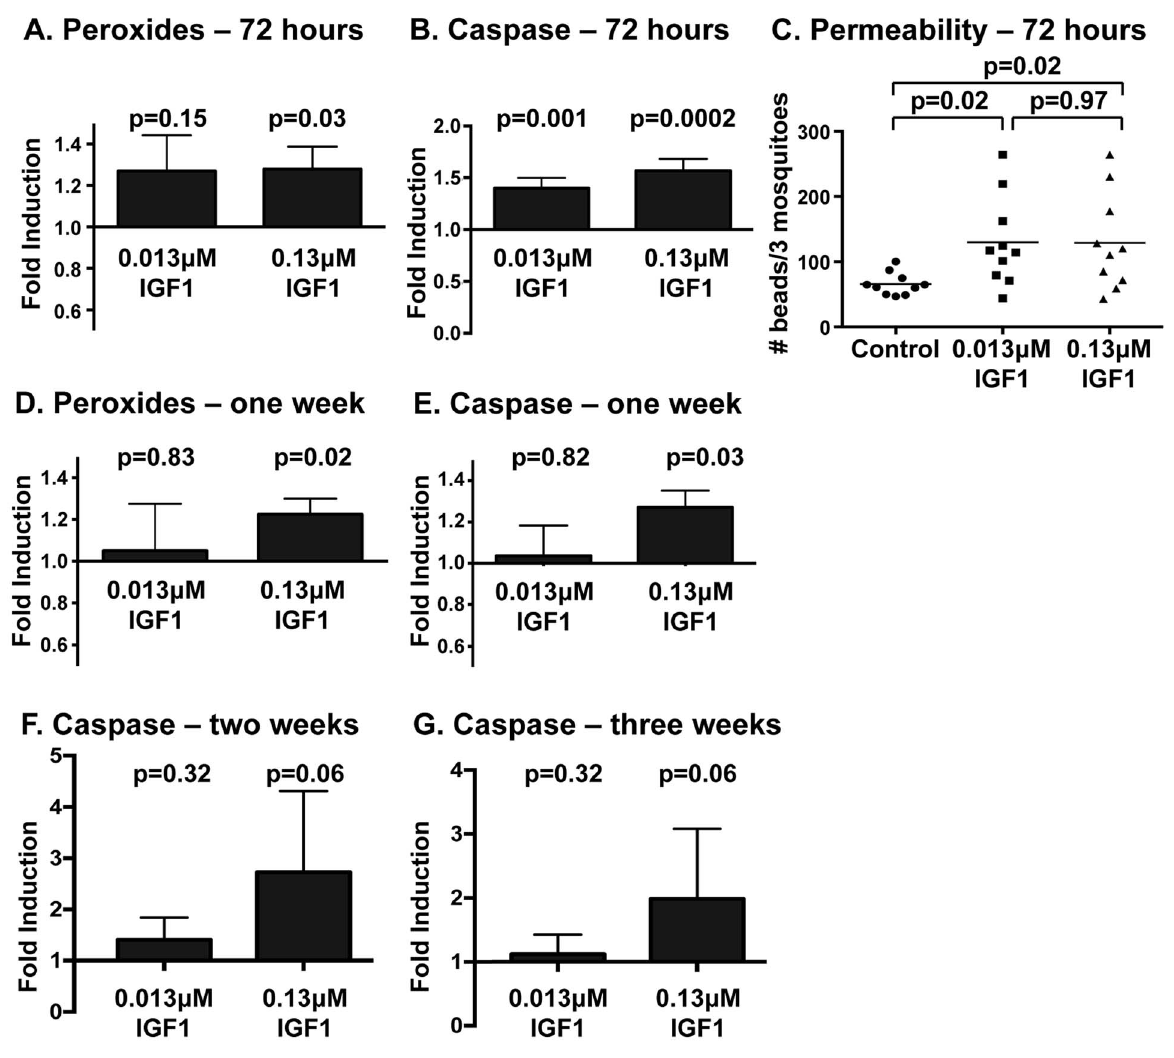
Figure 6. Midgut peroxides and epithelial integrity were altered at 72 h and one week post-IGF1 feeding. Peroxide levels in midguts at 72 h (A) and one week (D) following IGF1 treatment. Peroxides were quantified in pools of five midguts; three pools were collected per treatment per experiment. Experiments were replicated three times with separate cohorts of mosquitoes. Graphs show the mean fold induction of peroxides 6 SEM in IGF1 treated groups relative to saline/ATP-fed controls. Statistical significance was determined by unpaired t-test and p-values are indicated. Midgut caspase-3 activity at 72 h (B), one week (E), two weeks (F), and three weeks (G) following IGF1 treatment. Graphs show the average fold induction 6 SEM of AFC fluorescence (caspase-3 activity) relative to controls. Three pools of five midguts per treatment were collected for 72 h and one week timepoints and 1–2 pools were collected for two and three week timepoints. Experiments were replicated 4–6 times with separate cohorts of mosquitoes. Caspase-3 activity among groups was compared using Kolmogorov-Smirnov test. (C) Midgut permeability at 72 h following a blood- meal containing IGF1 and 3–3.5 m m fluorescent beads (Spherotech). Each data point represents the number of fluorescent beads in three whole mosquitoes quantified by flow-cytometry. Statistical significance was determined by one-way ANOVA followed by Fisher’s